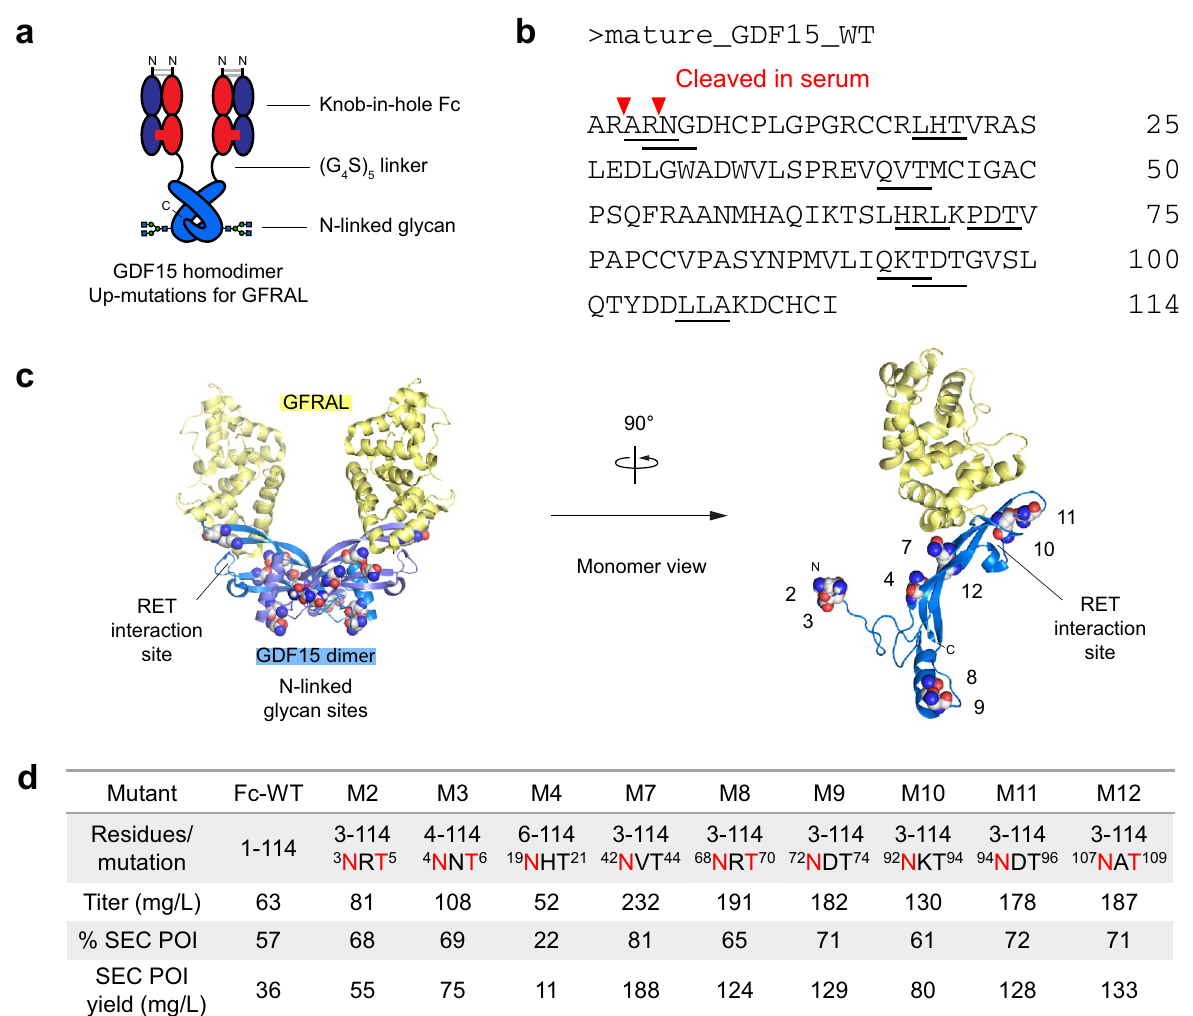
Figure 1. Fc fusion and N-linked glycans improve the production profile of GDF15. ( a ) Schematic representation of proposed Fc-glyco GDF15 therapeutic. Red, Knob-Fc chain. Blue, Hole-Fc chain. Light blue, mature GDF15 homodimer. N and C termini are highlighted. ( b ) Mature GDF15 amino acid sequence (UniProt Q99988, PRO_0000033993). Sites to introduce N-linked glycosylation are underlined. Red, putative serum cleavage sites. ( c ) Location of introduced N-glycan sites modeled on the GDF15-GFRAL crystal structure (PDB 5VZ4) using The PyMOL Molecular Graphics System, Version 2.0 Schrödinger, LLC (https:// pymol. org/). Introduced asparagine (N) mutations are shown as spheres. Numbers correspond to glyco-variant number (eg. Mutant 2). ( d ) Summary of Fc-GDF15 NxT mutant expression and purification yields, including expression titer (mg/L), Protein of Interest (POI) percentage following size exclusion chromatography (SEC), and SEC